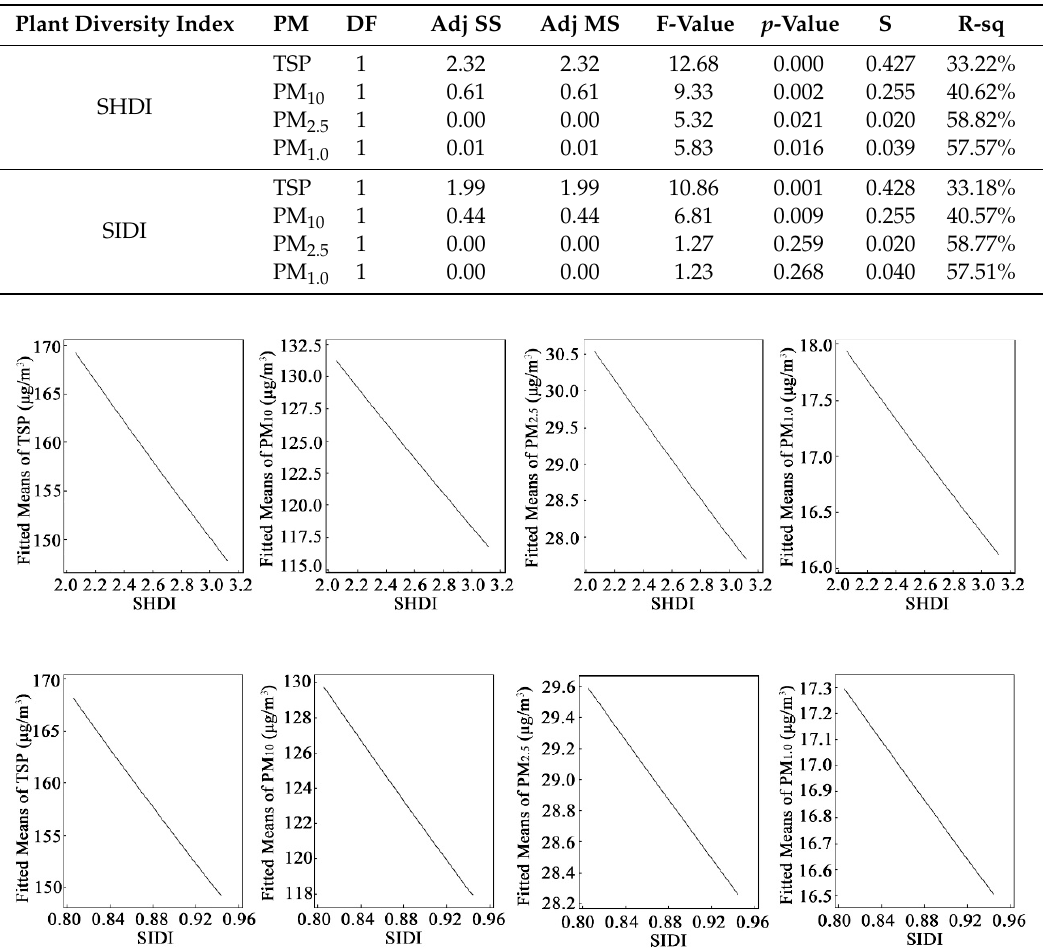
Figure 9. Relationship between plant diversity index and atmospheric suspended particulate matter concentration.